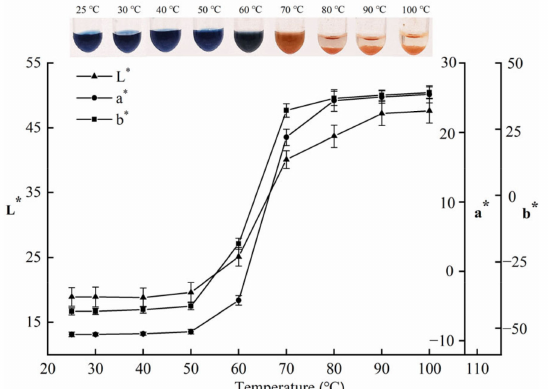
Figure 2. Colour changes of primary pigment proteins were obtained by 20–60% ammonium sulphate precipitation during the heat treatment from 25 to 100 ◦ C for 10